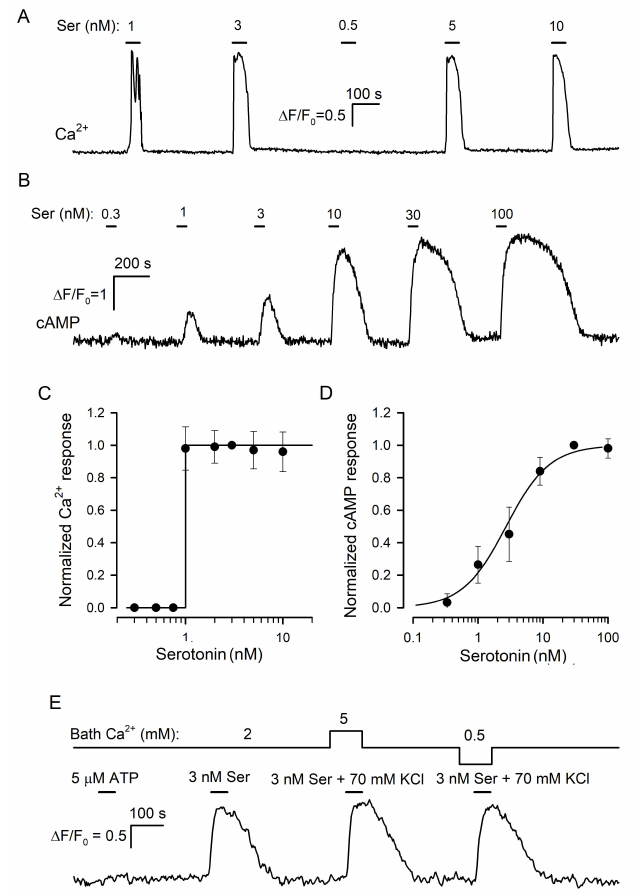
Figure 3. Serotonin biosensors. ( A ) Monitoring of intracellular Ca 2+ by Fluo-8 fluorescence in a 5-HT 2C -positive CHO cell sequentially stimulated by serotonin at the indicated doses. ( B ) Monitoring of intracellular cAMP with the Pink Flamindo sensor in a HEK-293 cell expressing the 5-HT 4 receptor. Serotonin was applied serially as indicated. ( C ) Dose–response curve for the 5-HT 2C -biosensor. In each particular experiment, a Ca 2+ transient ( ∆ F/F 0 ) elicited by serotonin at a given dose was normalized to a serotonin response at 3 nM. The data (cycles) are presented as the mean ± S.D. ( n = 46). The solid line represents the Heaviside step function H(S-1) with S being serotonin concentration. ( D ) Dose–response curve for the 5-HT 4 /PF biosensor. In each particular experiment, cAMP responses to serotonin at varied doses were normalized to a cAMP transient elicited by 30 nM serotonin. The data (cycles) are presented as the mean ± S.D. ( n = 31). The solid line represents the Hill equation R = S n /(S 0.5n + S n ) for the normalized cAMP response R with the Hill coefficient n = 1.3 and the half-effect concentration S 0.5 = 27 nM. ( E ) Representative control experiment (27 cells) indicating that the 5-HT 4 /PF biosensor was insensitive to micromolar ATP and that its responsiveness to